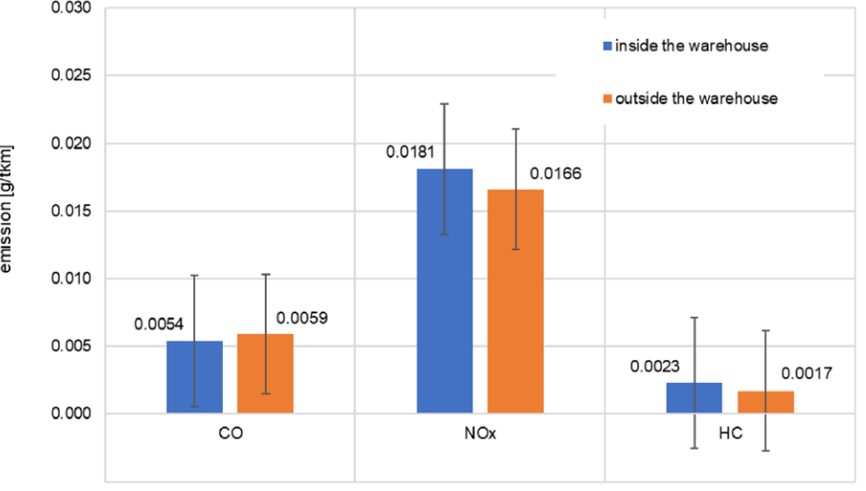
Figure 9. Comparison of the emissions referred to the handling operation of the tested forklift.